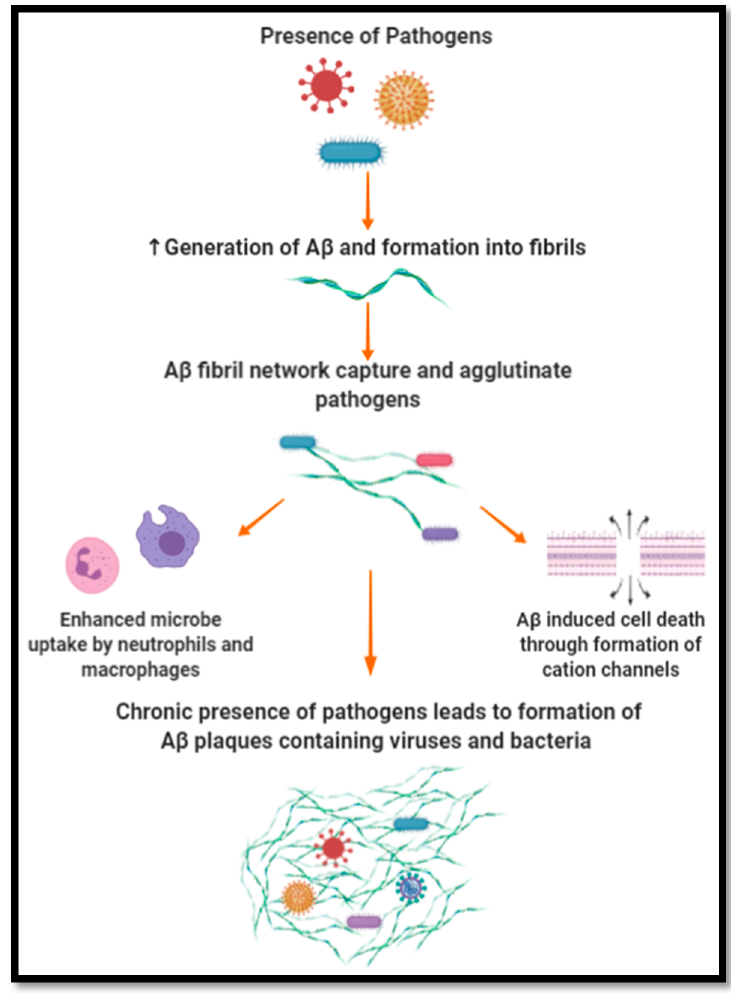
Figure 2. A β as an antimicrobial peptide.